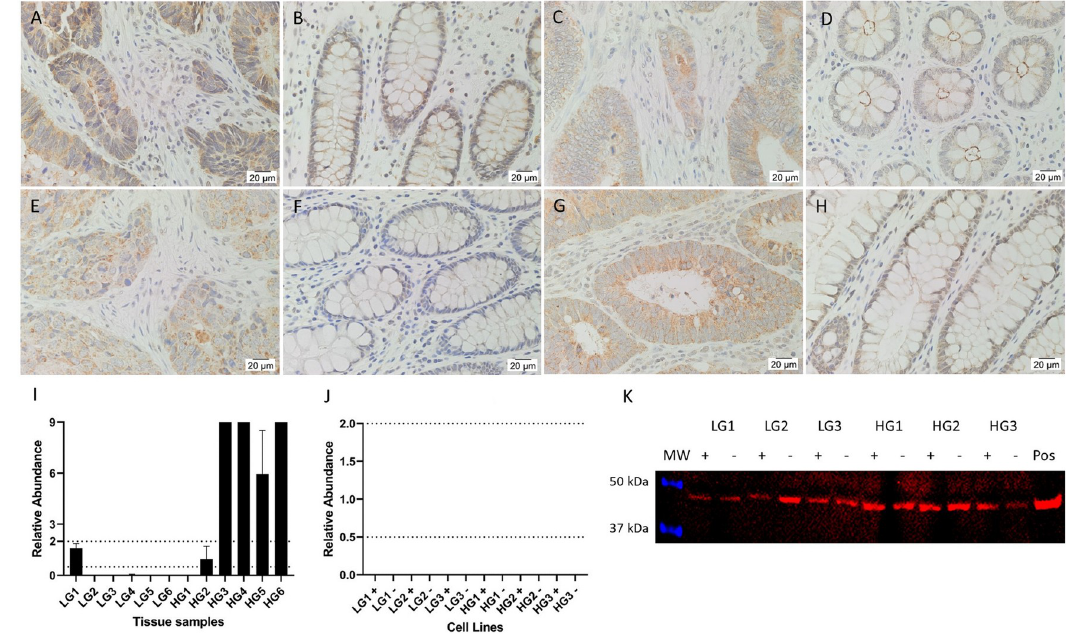
Fig 2. Expression of AT 2 R. Representative IHC stained images of AT 2 R (brown), including 2 LGCA samples (A, C) and their patient-matched NC tissues (B, D), and 2 HGCA samples (E, G) and their patient-matched NC tissues (F, H). Nuclei were counterstained with hematoxylin (A-H, blue); original magnification: 400x. AT 2 R mRNA expression levels were measured by RT- qPCR in 6 LGCA and 6 HGCA tissues (I) and in 3 LGCA and 3 HGCA primary cell lines that were sorted into EpCAM High (+) and EpCAM Low (-) subpopulations (J). Abundance in CA tissues is displayed relative to patient-matched NC tissues, and relative to a pool of NC tissues for the CA-derived cell lines, with error bars representing standard deviation. PRR protein expression by cell lines was detected by WB (K; 45 kDa); positive control = HepG2 cells. Adapted from [38]. under a CC BY license, with permission from Munro MJ et al . 2021.